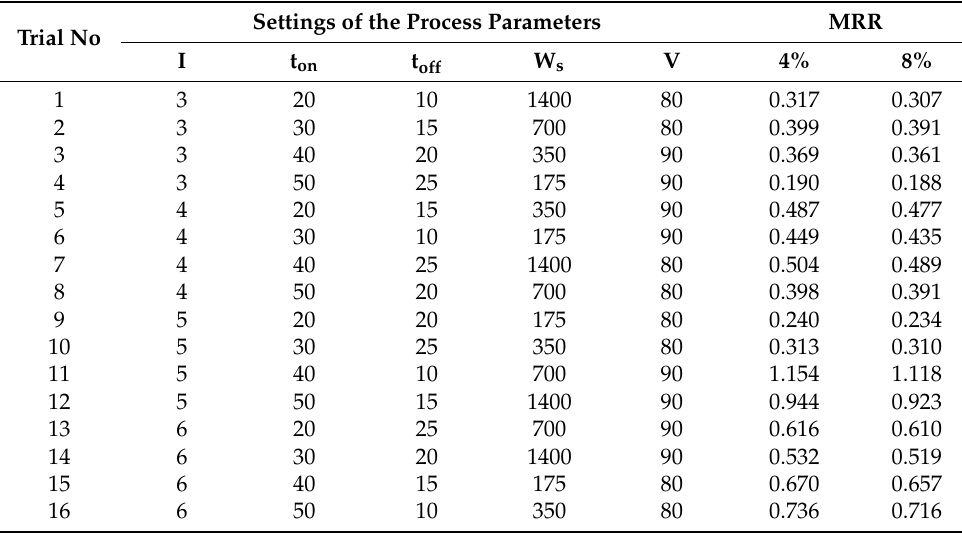
Table 3. The experimental design and corresponding average MRR.